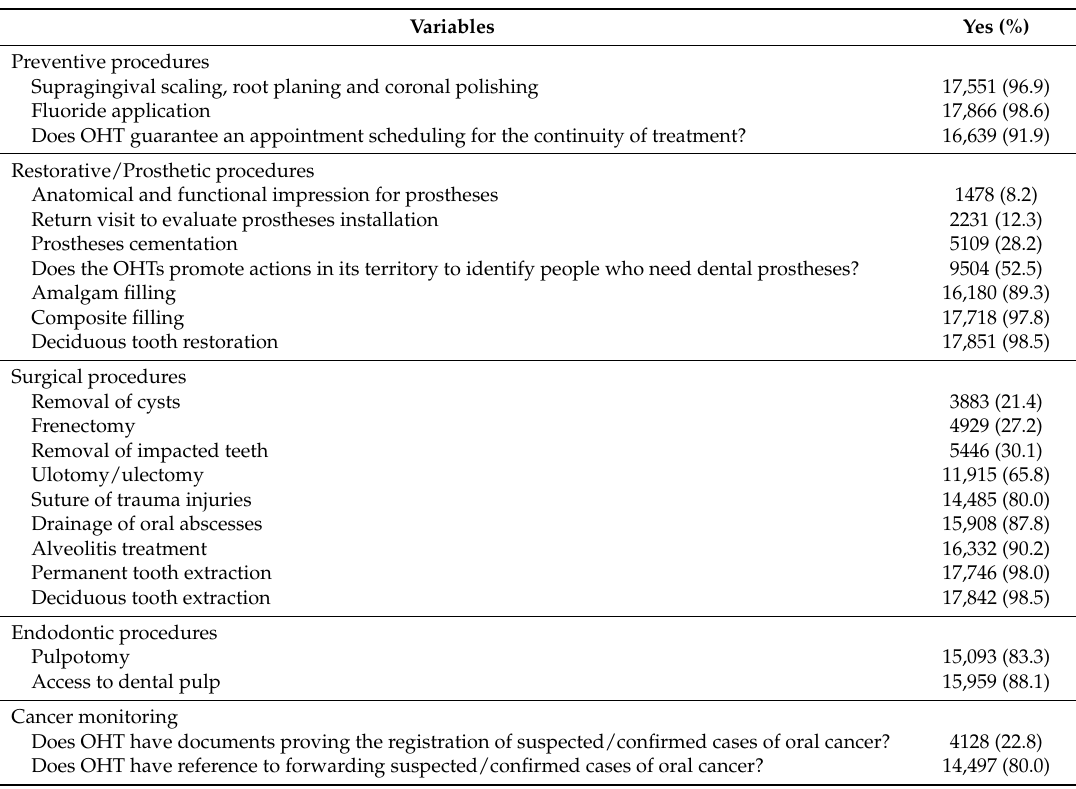
Table 1. Basic dental procedures performed by oral health teams, Brazil,